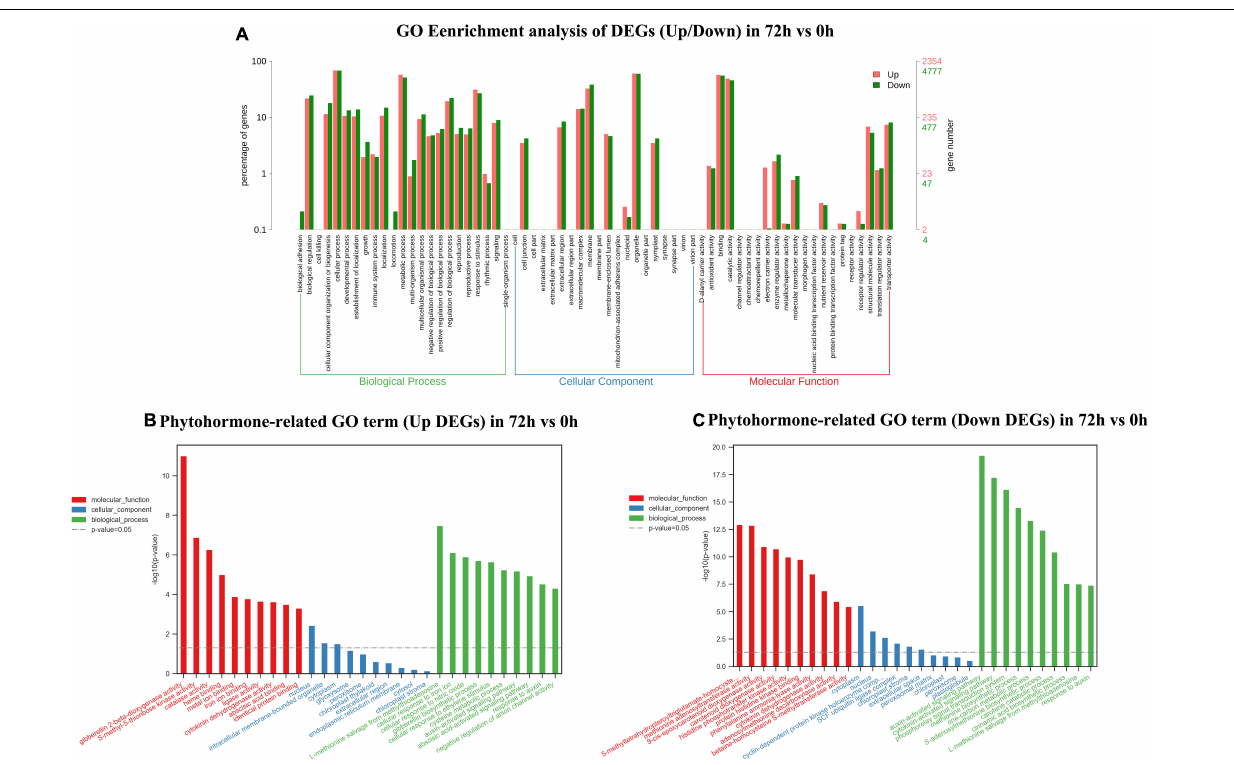
FIGURE 5 | Gene ontology enrichment analysis of up/down DEGs (A) , phytohormone-related GO terms (up DEGs) (B) , and phytohormone-related GO terms (down DEGs) (C) in 72 vs. 0 h.